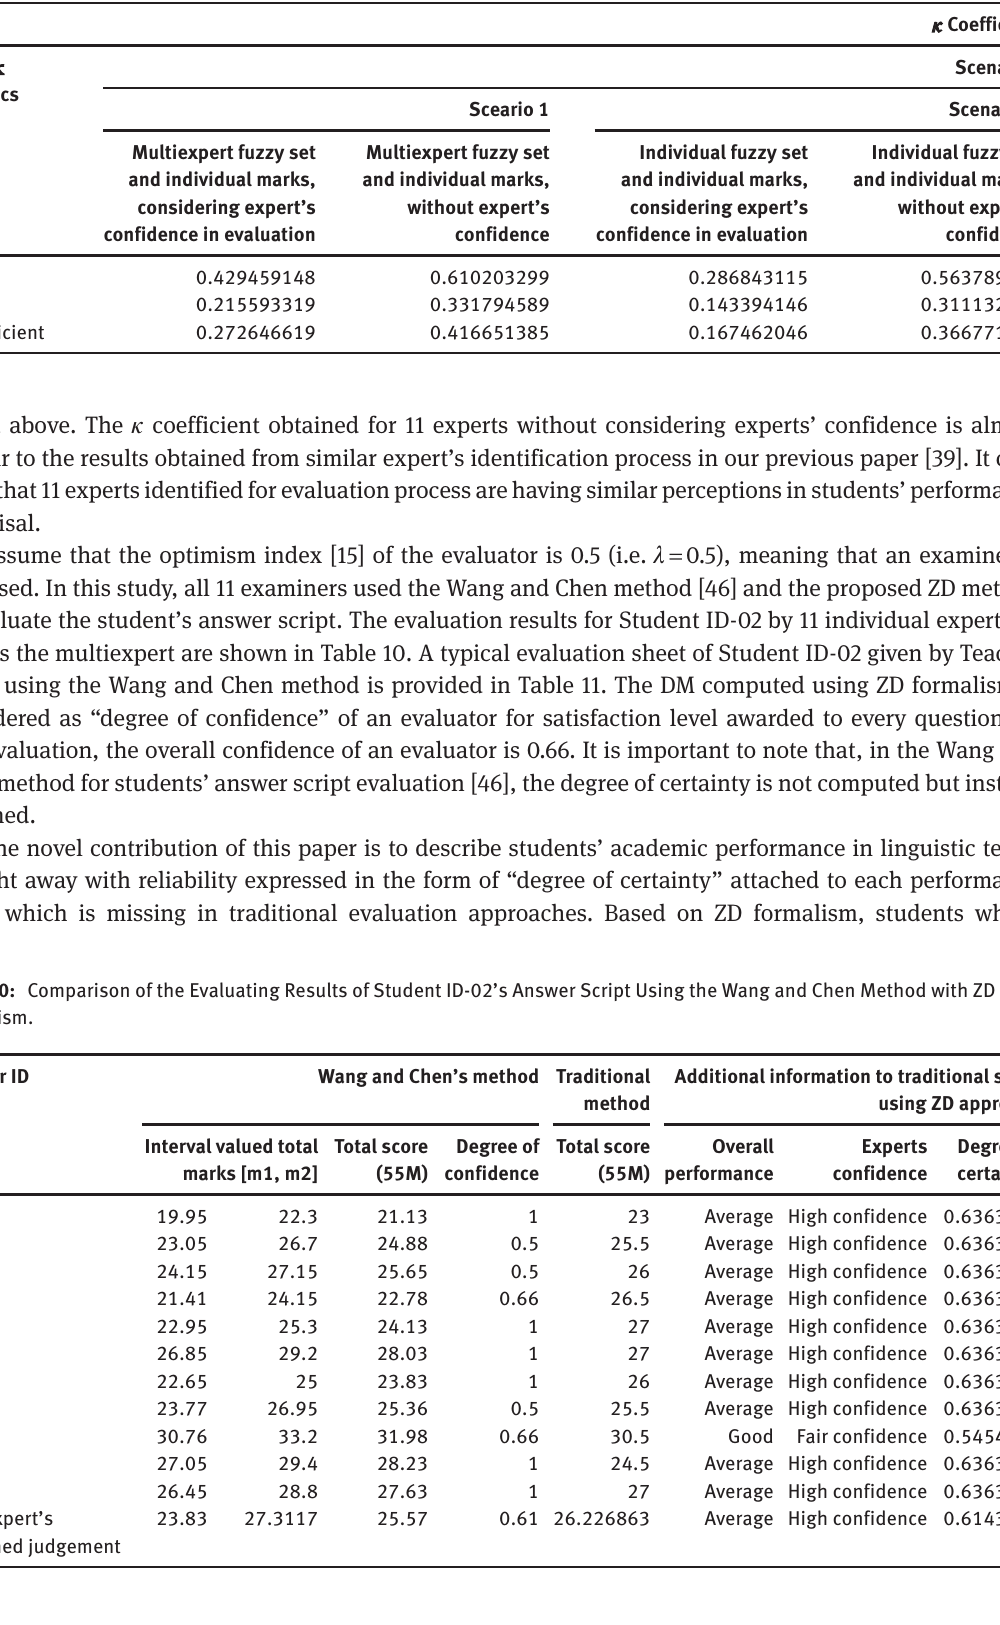
Table 9: Summary of Interrater Reliability Among 11 Experts in Scenarios 1 and 2 with or without Expert’s Confidence in students’ Performance Evaluation Using ZD Formalism.